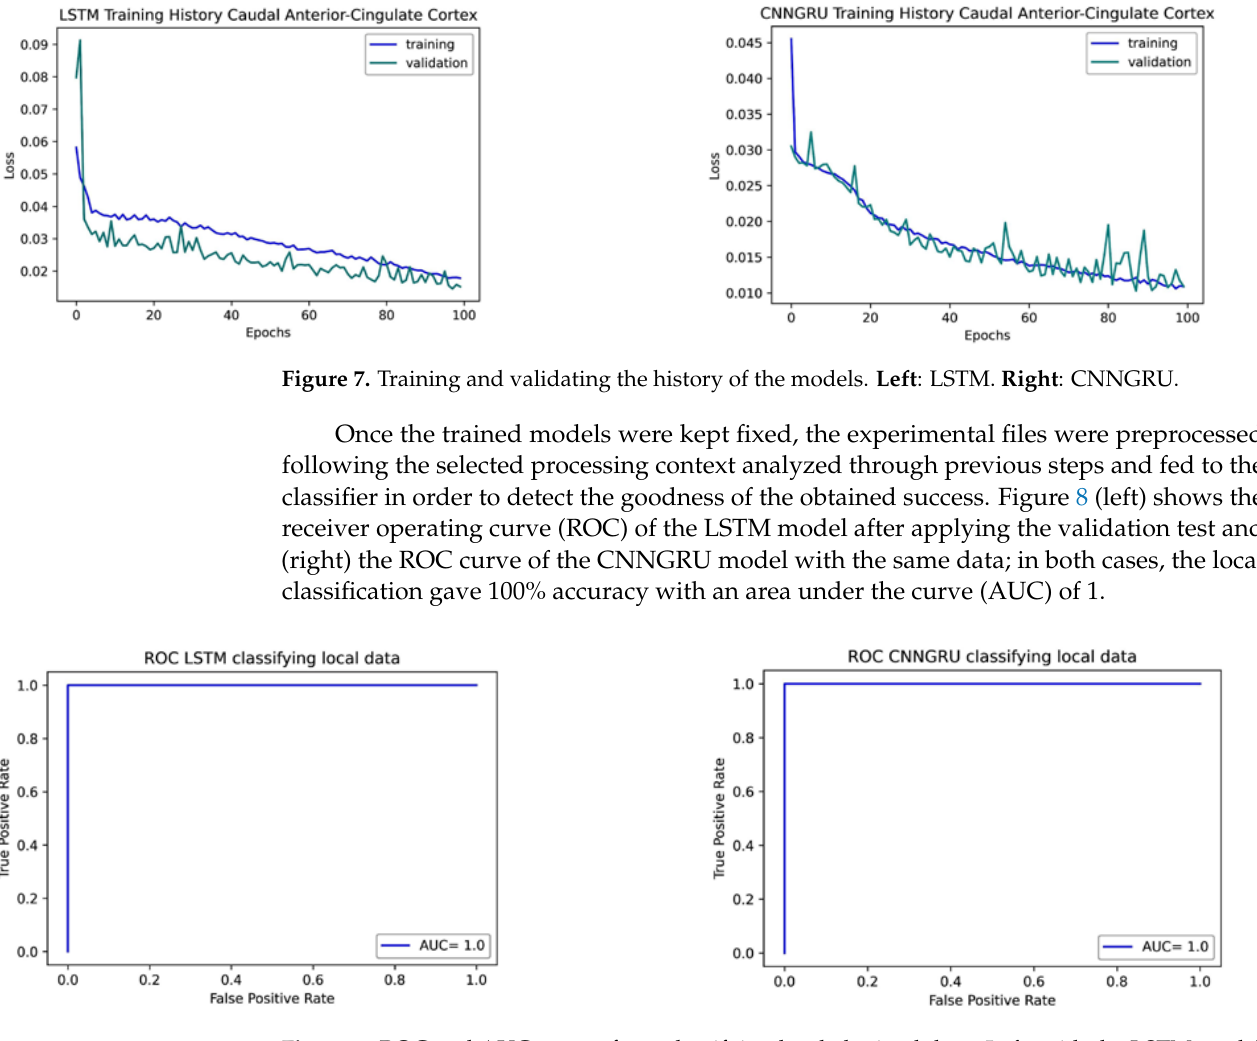
Figure 8. ROC and AUC curves from classifying local obtained data. Left : with the LSTM model. Right : with the CNNGRU model.